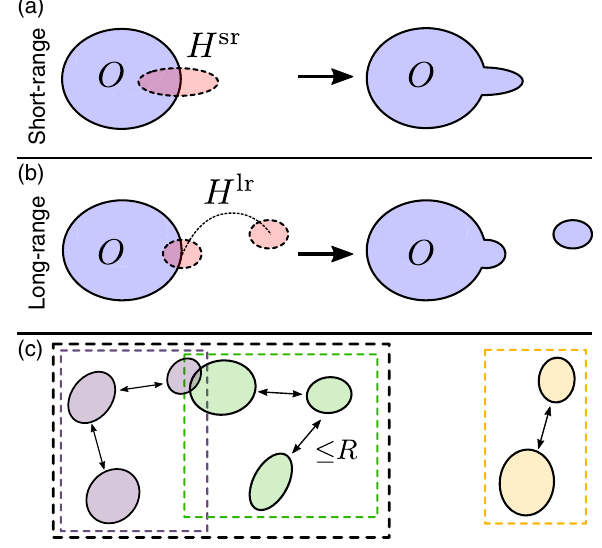
FIG. 2. (a) [(b)] Illustration of operator spread via the action of a short- [long-]range Hamiltonian, Eq. (17) [Eq. (19)]. In the short-range case (a), the operator remains close to its original location. For the operator to spread to a far away location, it requires many actions of H sr , which leads to a correspondingly large increase in its support; the range and support are closely related notions of size. In the long-range case (b), this need not be the case. The operator can very quickly spread across the system without a significant increase to its support; the range and the support of the operator capture very different notions of size. (c) An R -ranged set is a set where any two elements can be connected via a sequence of “ jumps ” (within the set) of size no greater than R . We illustrate this concept with the gray, green, and orange sets, each representing a different R -ranged set. Crucially, this definition is closed: when two R -ranged sets have a non- empty intersection, their union is also an R -ranged set (e.g., the gray and green sets). If they do not intersect, the union of two R - ranged sets need not form an R -ranged set (e.g., the green and orange